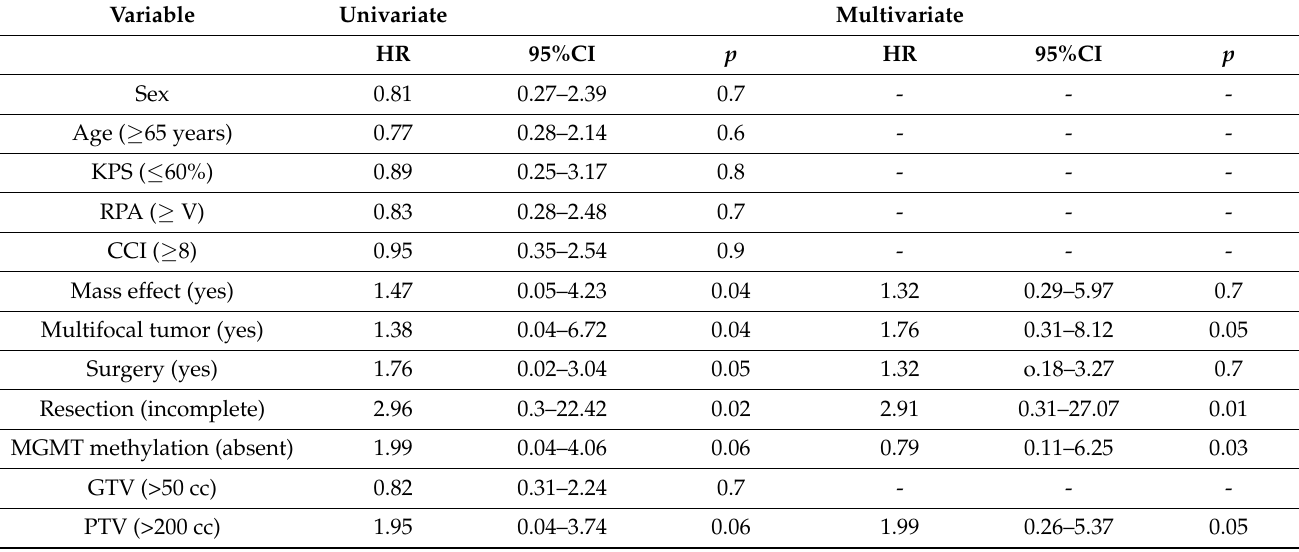
Table 3. Univariate and multivariate analysis of prognostic factors for progression-free